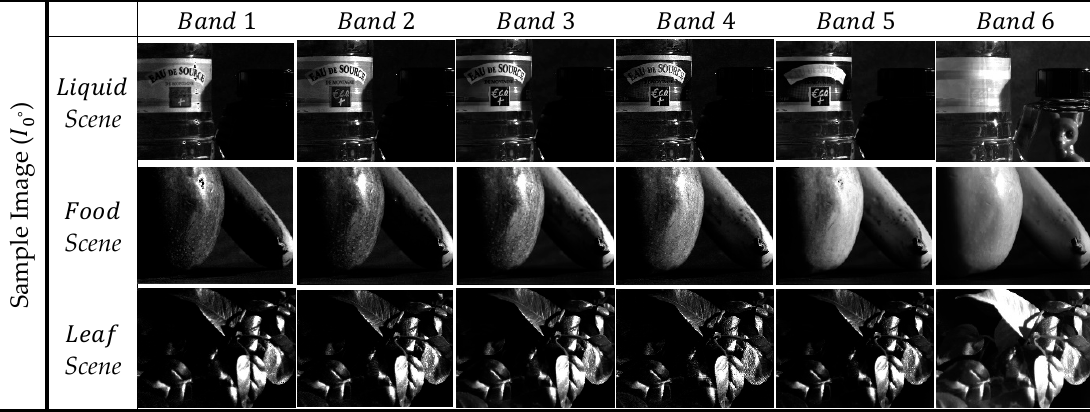
Figure 1. Samples of MSPI dataset scenes composed of six spectral channels and four polarimetric orientations [60].